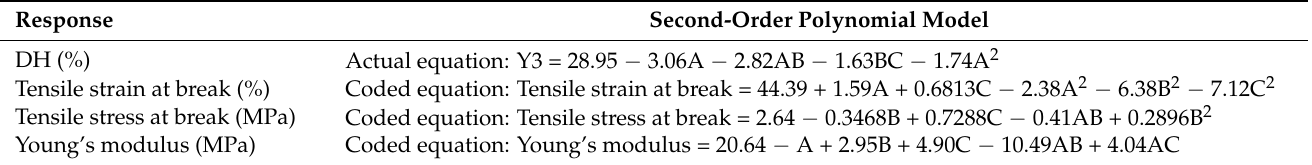
Table 5. Second-order polynomial equations for the models and the regression